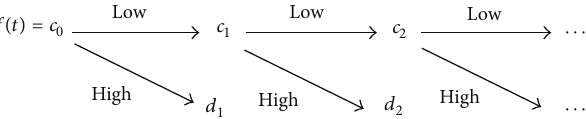
Figure 1: The 1D wavelet decomposition